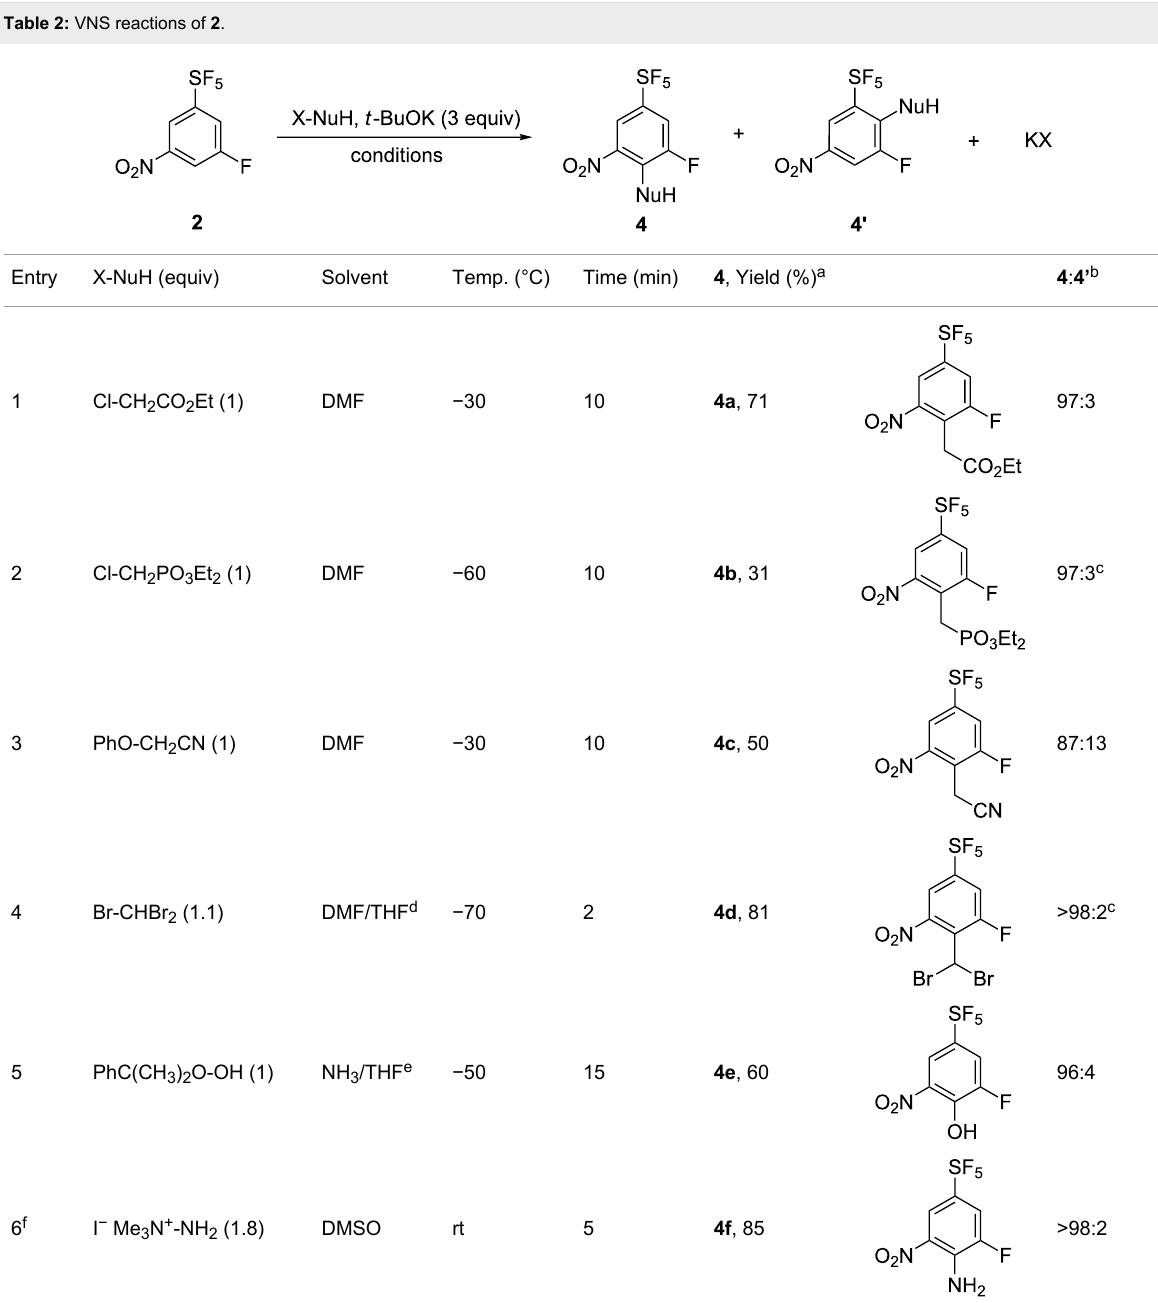
Table 2: VNS reactions of 2